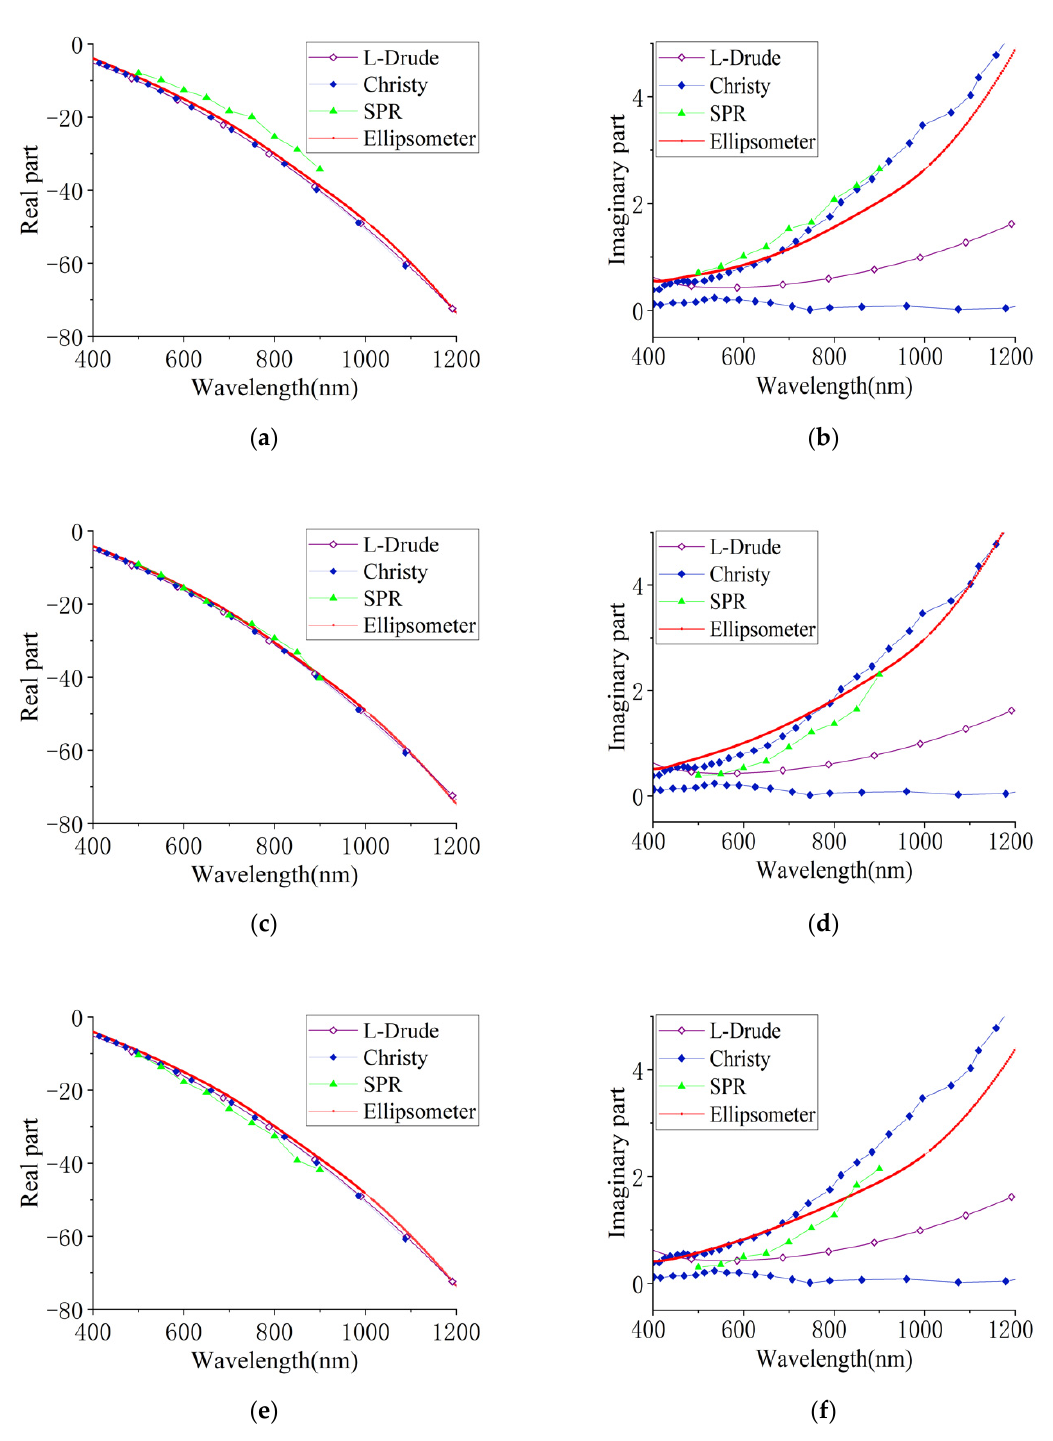
Figure 5. The dielectric constant theoretical fitting and experimental measurement results of ( a,b ), 45 nm ( c,d ), and 55 nm ( e,f ) silver films.